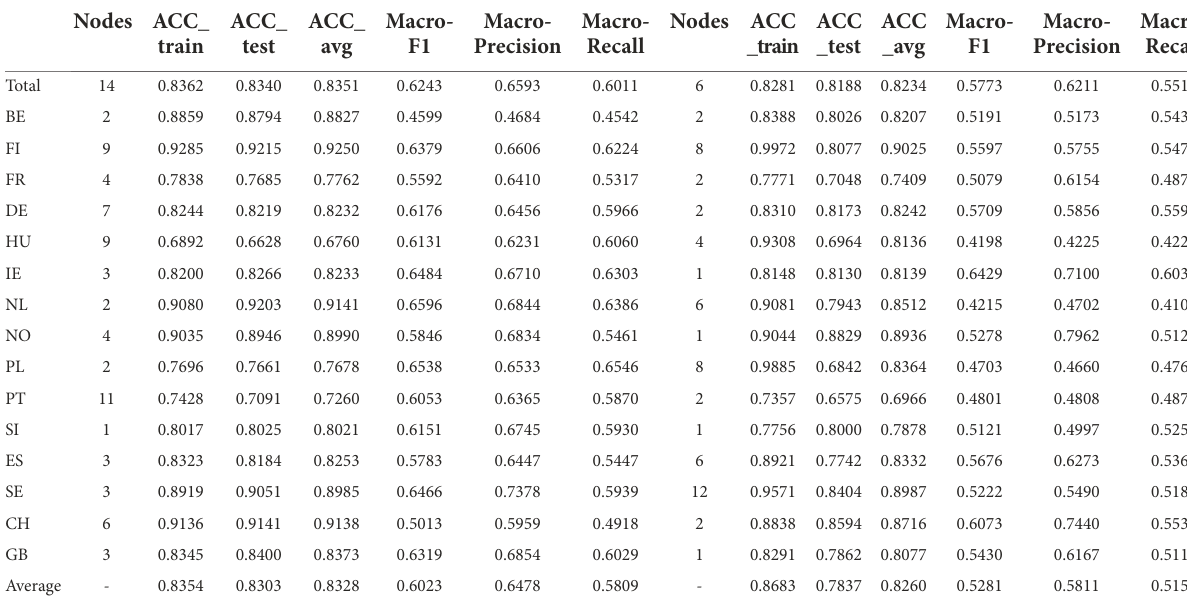
TABLE 6 The performance metrics of ANN models. Native groups Immigrant